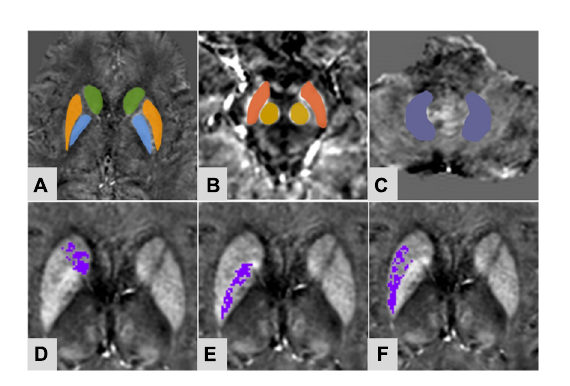
FIGURE1 A 61-year-old female of PDDM group. Regions of interest selected on susceptibility maps. (A) Green-caudate nucleus; orange-putamen; blue-globus pallidus; (B) Red-substantia nigra; yellow-red nucleus; (C) purple-dentate nucleus. Panels (D–F) were based on the MSV threshold, the purple regions were the obtained high iron content region of the corresponding nuclei. (D) Right caudate nucleus; (E) right globus pallidus; (F) right putamen.